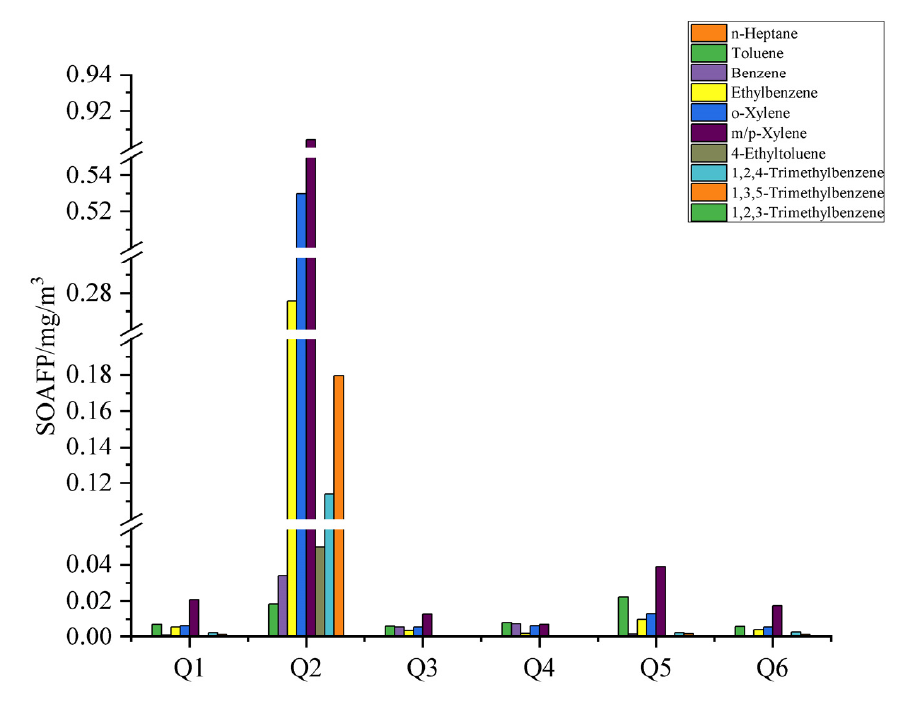
Figure 6. Contribution of different components to SOA.